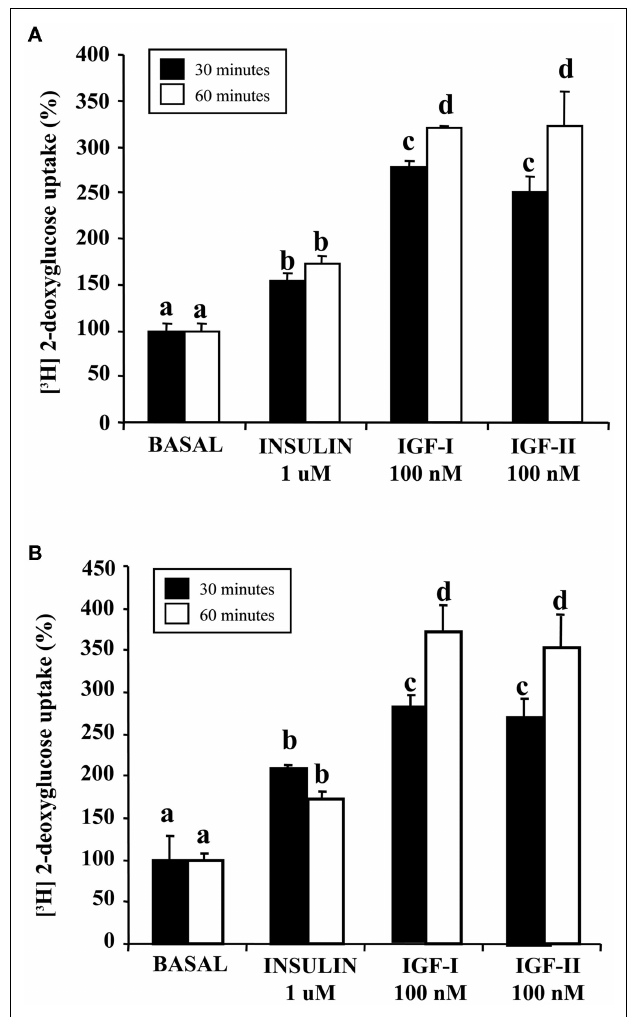
FIGURE 2 | Effect of insulin, IGF-I, and IGF-II on 2-deoxyglucose uptake in sea bream muscle cells. Cells were isolated and cultured for 4days to have myocytes (A) or 9days to obtain small myotubes (B) and incubated with the peptides, IGF-I or IGF-II (both at 100nM) or insulin (1 μ M) for 30 or 60min, and subsequently incubated with labeled 2-deoxyglucose (2-DG) for 30 additional min. Results are expressed as percentage of stimulation above basal levels and means ± SE ( n = 3 experiments). Statistical differences between conditions were analyzed by one-way ANOVA followed byTukey’s post hoc test. Different letters indicate significantly ( P < 0.05) different values among groups.